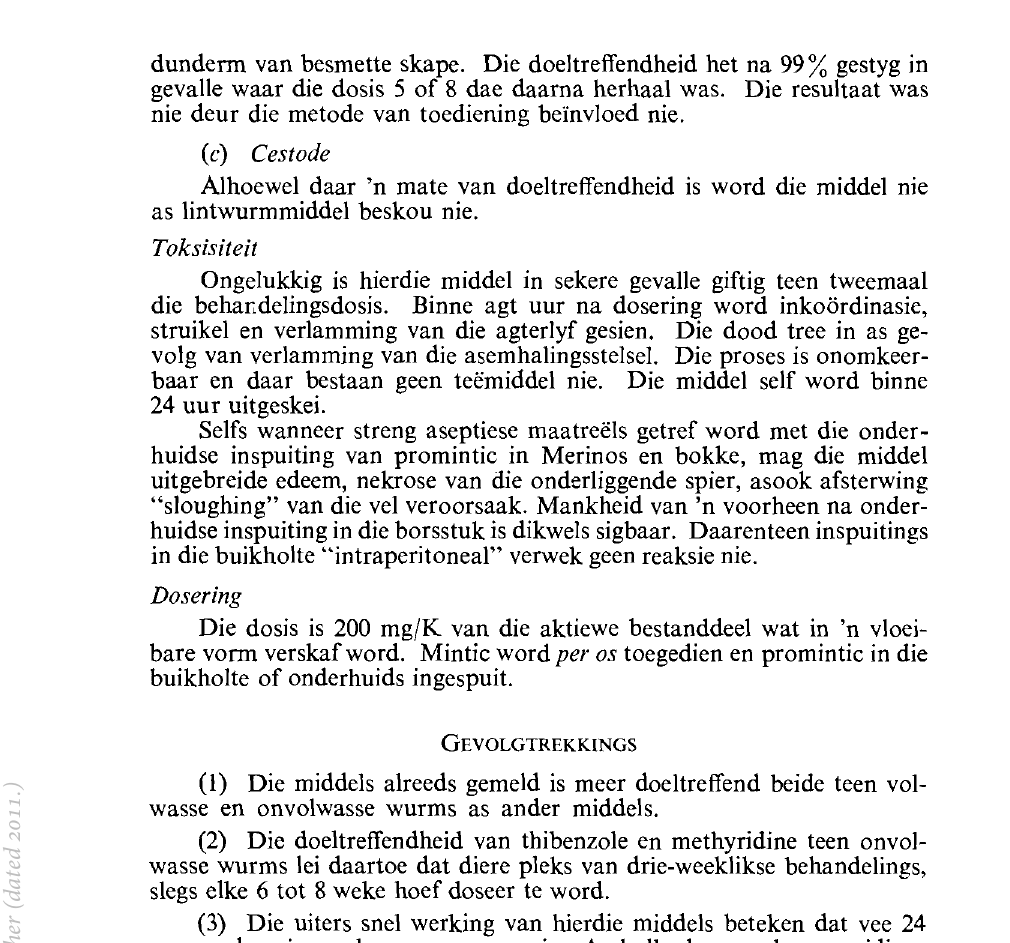
Toksisiteit Onge1ukkig is hierdie middel in sekere gevalle giftig teen tweemaal die behar;delingsdosis. Binne agt uur na dosering word inkoordinasie, struikel en verlamming van die agterlyf gesien. Die dood tree in as ge volg van verlamming van die asemhalingsstelseI. Die proses is onomkeer baar en daar bestaan geen teemiddel nie. Die middel self word binne 24 uur